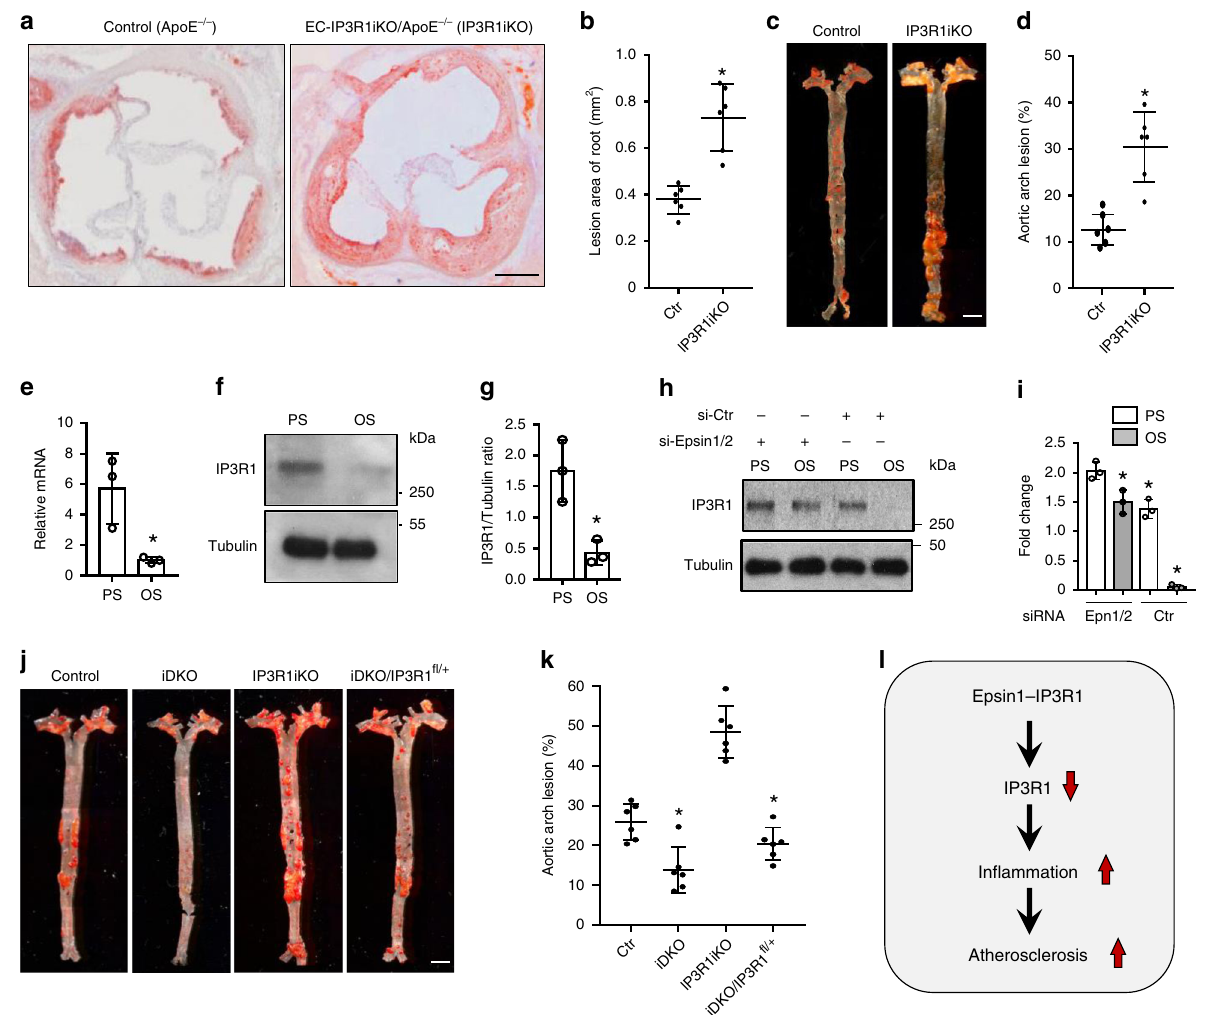
Fig. 7 Reduction of endothelial IP3R1 accelerates atherosclerosis. a to d ORO staining of atherosclerotic lesions in aortic roots ( a ) and arches ( c ) of control (ApoE − / − ) and EC-IP3R1iKO/ApoE − / − (IP3R1iKO) atherosclerotic mice fed a WD for 12 – 14 weeks. Statistical analysis of aortic roots and arches lesion are shown in ( b , n = 6 aortic roots) and ( d , n = 6 aortic arches), respectively (asterisk P < 0.001). Scale bars 500 μ m ( a ) and 5 mm ( c ). e – g Human aortic endothelial cells (HAECs) subjected to 12 ± 4 dynes/cm 2 pulsatile shear stress (PS) or 1 ± 4 dynes/cm 2 oscillatory shear stress (OS) for 16 h. IP3R1 mRNA ( e ) and prot e in ( f ) levels were determined by qRT-PCR and western blot analysis, respectively. Quantitation of western blot results ( g ) ( e – g , n = 3 independent repeats, asterisk P < 0.001). h , i HAECs subjected to PS or OS for 16 h in the presence of absence of epsin 1 and 2, followed by western blot ( h ) and statistical analyses ( i ) (epsin 1 vs. epsin 2, n = 3 independent repeats, asterisk P < 0.05; epsin 1 vs. Ctr, n = 3 independent repeats, asterisk P < 0.003; epsin 2 vs. Ctr., n = 3 independent repeats, asterisk P < 0.005;). j , k ORO staining of aortic arches of control, iDKO, IP3R1iKO, and iDKO/IP3R1 fl / + mice fed a WD for 26 – 28 weeks ( j ). Scale bar 500 µ m. Quanti fi cation of ORO staining showing rescue of atherosclerosis progression in iDKO/IP3R1 l/ + compared to iDKO mice ( k ) ( n = 6 aortic arches in each group, asterisk P < 0.001). l Schematic diagram of endothelial epsin-mediated IP3R1 degradation and acceleration of in fl ammation and atherosclerosis. All data were assessed using Student ’ s t -test and are presented as the mean ±